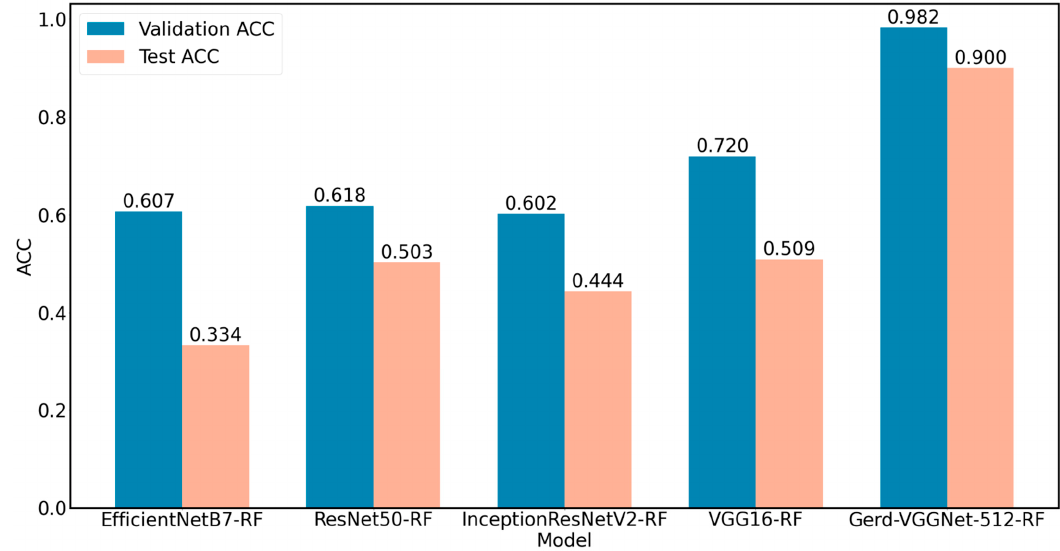
Figure 4. Comparison of Performance of five feature extractors.